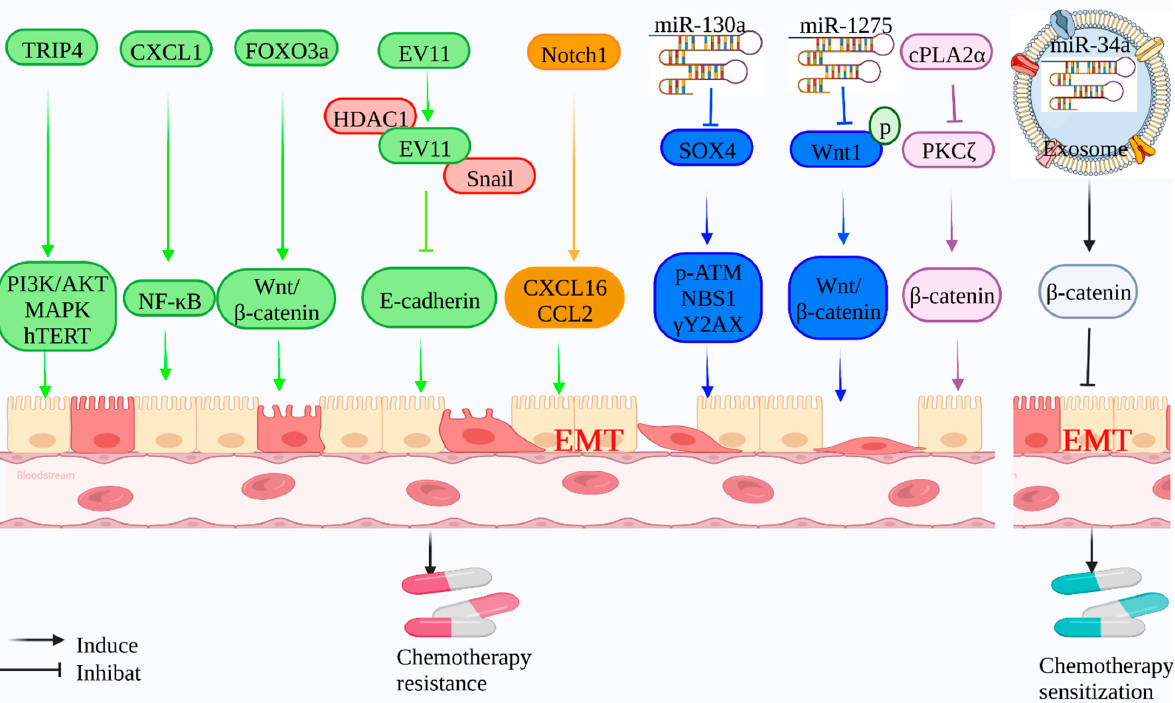
Figure 2. Mechanism of EMT-mediated radiotherapy resistance: Tumor-associated genes can me- diate the radiation resistance of tumor cells by inducing EMT. Tumor-related proteins (TRIP4, CXCL1, FOXO3a, Notch1, and cPLA2 α ) can induce EMT through related signaling pathways (PI3K/Akt, NF- κ B, Wnt/ β -catenin, CCL2/CXCL16, and PKC ζ / β -catenin) and enhance the radiotherapy tolerance of cervical cancer, glioblastoma, and nasopharyngeal carcinoma. EVI1 inhibits E-cad- herin expression and induces EMT by forming a co-inhibitory complex with Snail and HDAC1 and enhances the radiotherapy tolerance of nasopharyngeal carcinoma. Tumor-associated non-coding RNAs (Mir-130a and Mir-1275) inhibit target proteins (SOX4 and WNT1), further influencing related proteins (NBS1, P-ATM, and γ H2AX) and related signaling pathways (Wnt/ β -catenin) to induce EMT and enhance the radiotherapy sensitivity of colorectal cancer and esophageal cancer. Mean- while, in response to EMT-mediated radiotherapy resistance, exosome Mir-34A can target the ex- pression of β -catenin, delay the progression of EMT, and improve the radiotherapy sensitivity of NPC.